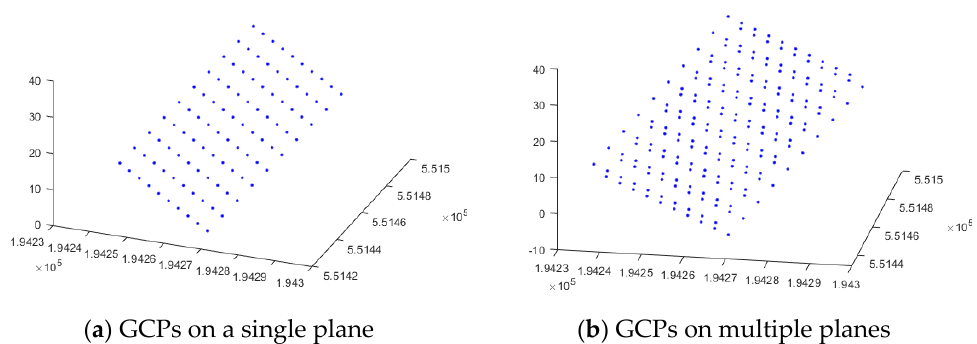
Figure 9. Three − dimensional distribution of GCPs. Figure 9. Three—dimensional distribution of